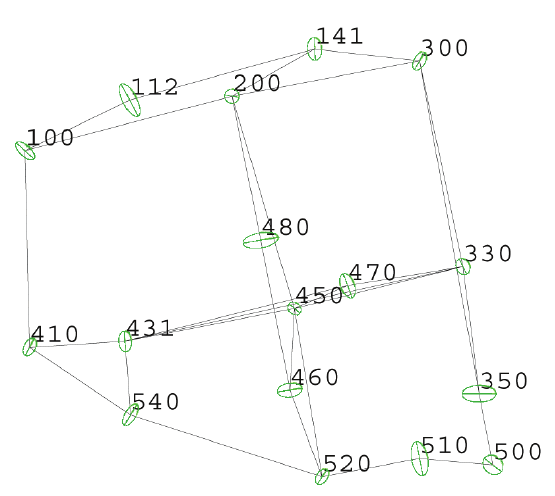
Figure 1. Geodetic network for the test area of 300 m x 300 m: GNSS measurements on points 100, 300 and 500, green ellipses show (scaled) standard deviation of points. The largest error occurs at point 480, where the main axis of the ellipse has a length of 1.1